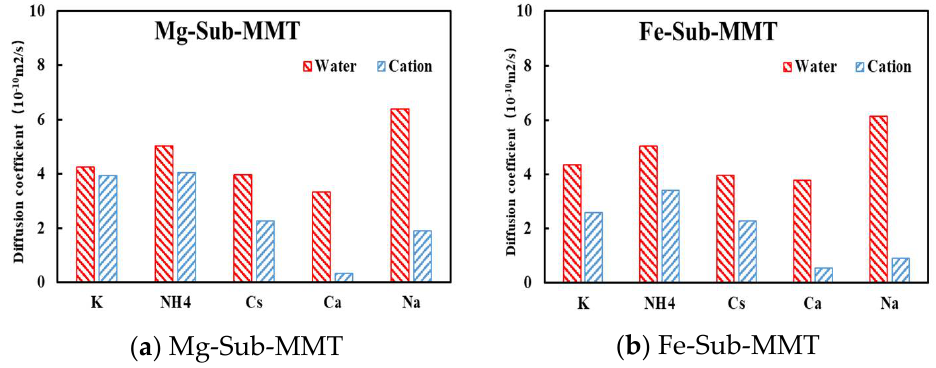
Figure 5. Diffusion coefficient of counterions and water in different MMT